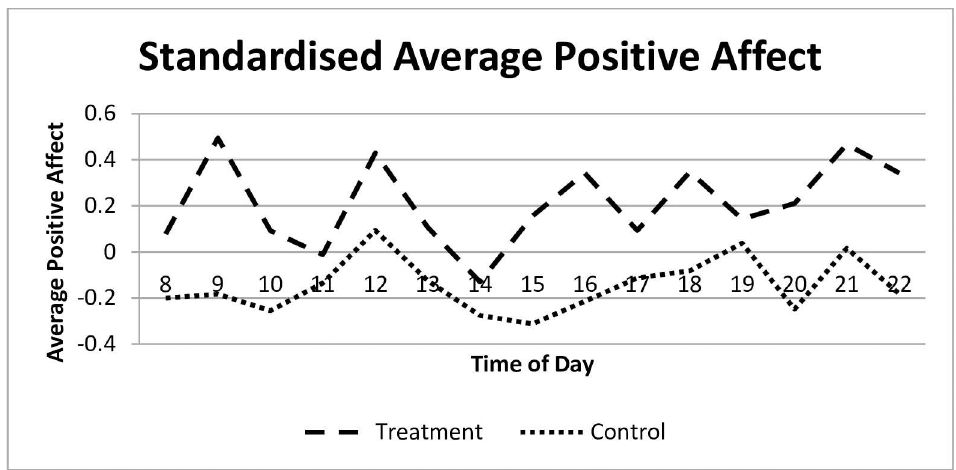
Fig 2. Standardized averagepositive affect for treatment and control